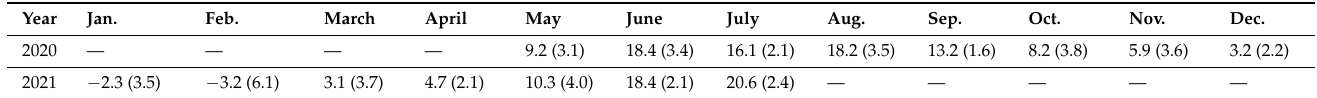
Figure 7. Harrowing study, 2020–2021: Larval yield (mean kg DM grass ± SD) in the harrowed pasture (pasture A) and control pasture (pasture B) and weekly rainfall (mm) in each sampling week (1–63). Time of infection and harrowing are indicated with arrows. No sampling was performed during weeks 33–48 due to the ground being frozen. ** p < 0.01; **** p < 0.0001. All error bars cannot be graphically shown due to very low variation between readings. Table 1. Average (±SD) temperature during the harrowing study.